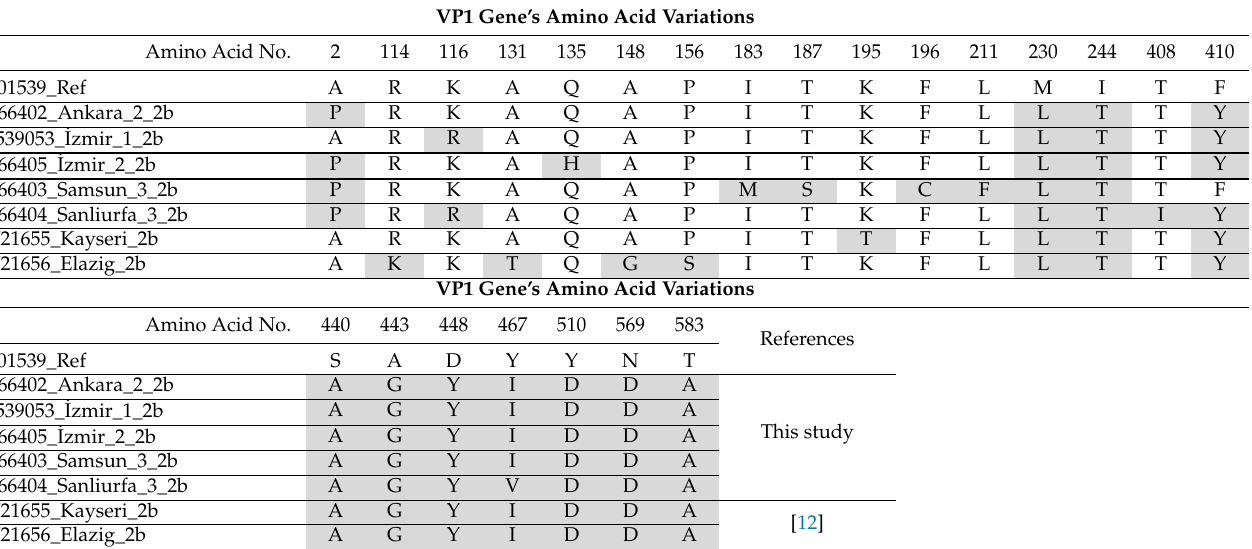
Table 2. VP1 gene’s amino acid variations.